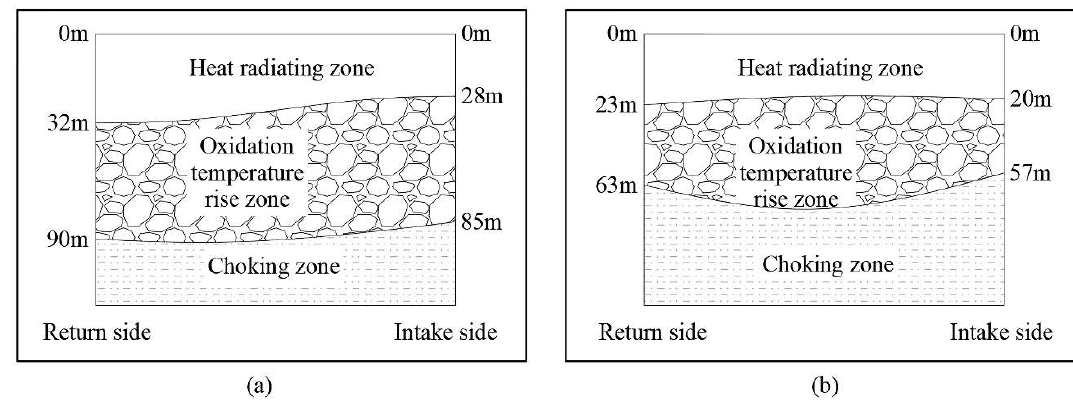
Figure 13. The variety of the three zones after injection of compound material into the goaf of the working face: ( a ) Before injection; ( b ) after injection [54].